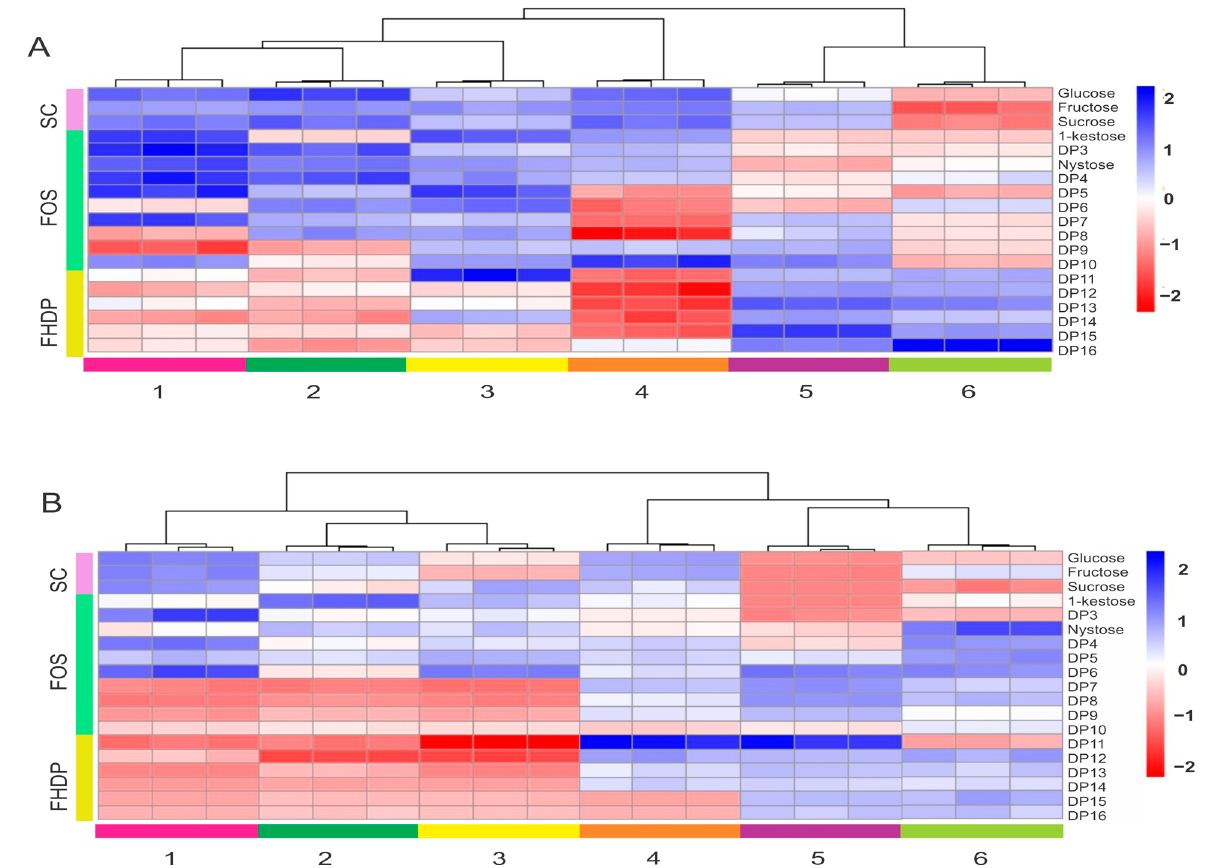
Figure 7. Hierarchical clustering analyses (HCA) and heatmaps of carbohydrate concentrations of agave plants at different ages. ( A ) Agave angustifolia; ( B ) Agave potatorum . Metabolites (carbohydrates) are represented by each row and listed on the right side of the heatmap, while each sample and its biological replicates are represented by columns. All peak areas were normalized to Z-scores for each carbohydrate. The color scale represents fold changes with respect to the average value of each metabolite, with the white color representing an average relative abundance, the blue color indicating a higher metabolite concentration than the median of the samples, and the red color indicating a lower concentration, as shown to the right of the color bar. Abbreviations: SC, simple carbohydrates; FOS, fructooligosaccharides; FHDP, fructans with a high degree of polymerization.